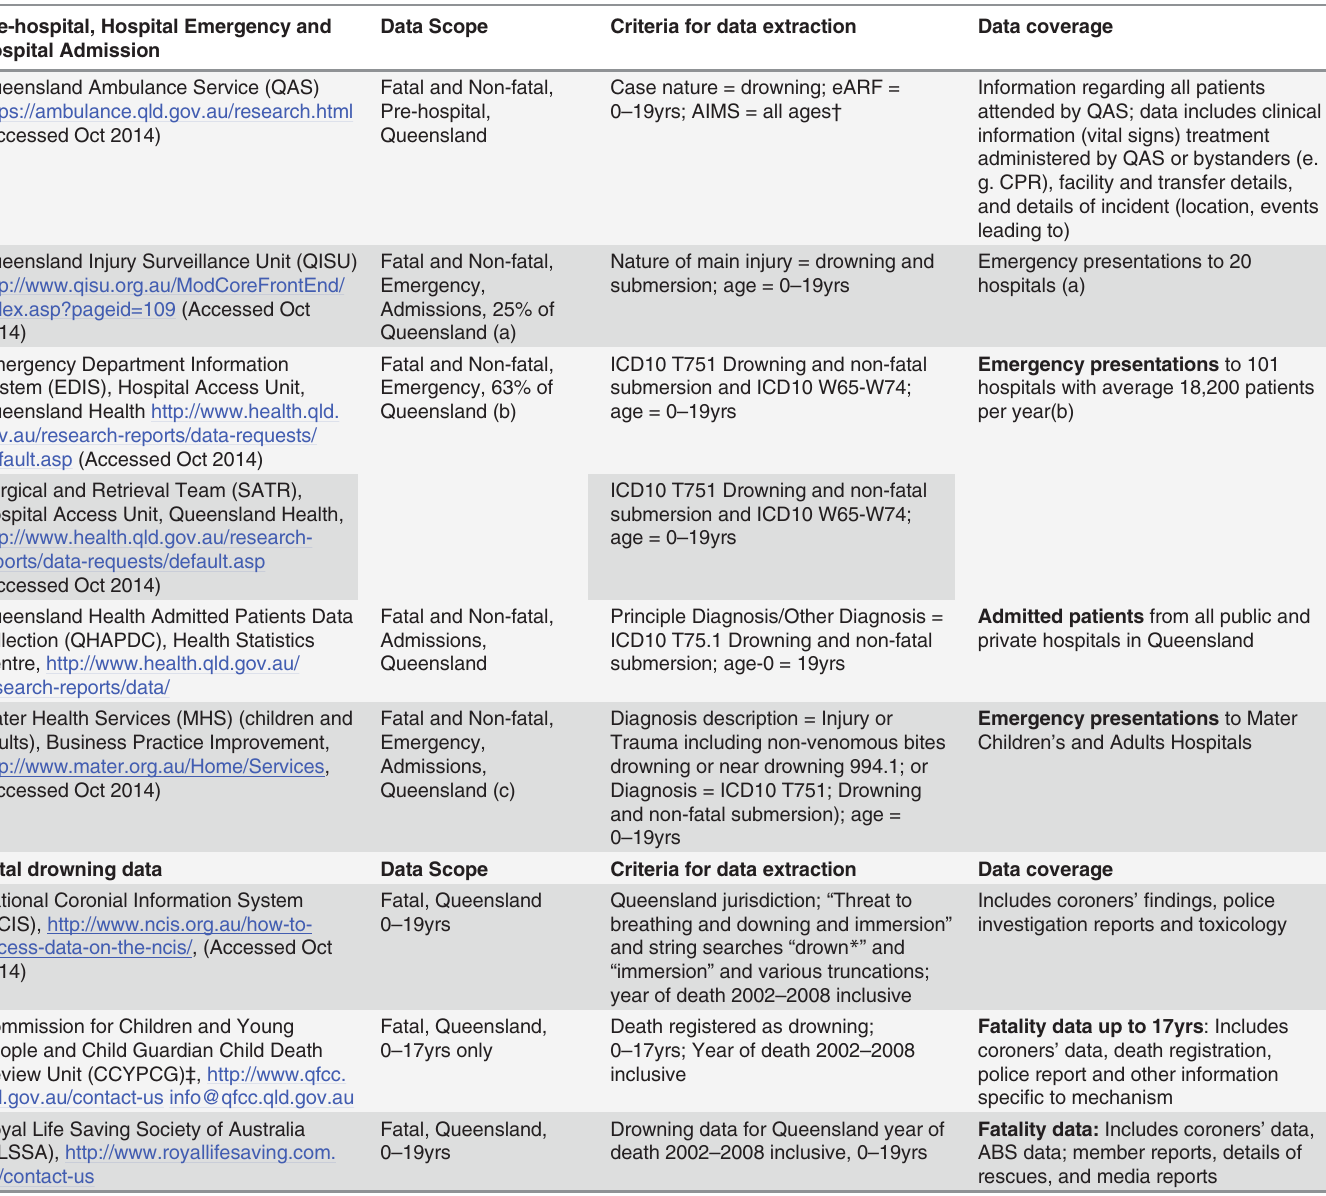
Table 1. Data custodians, scope and extraction criteria — 7 year review of Drowning in children and Adolescents in Queensland 2002 –